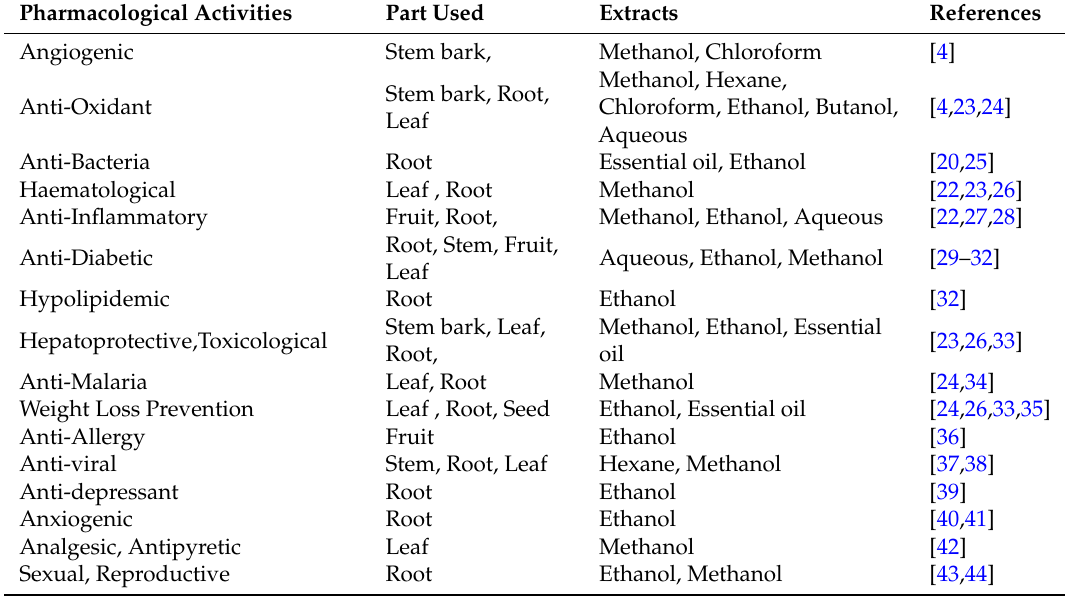
Table 2. Summary of pharmacological activities of S. jollyanum.